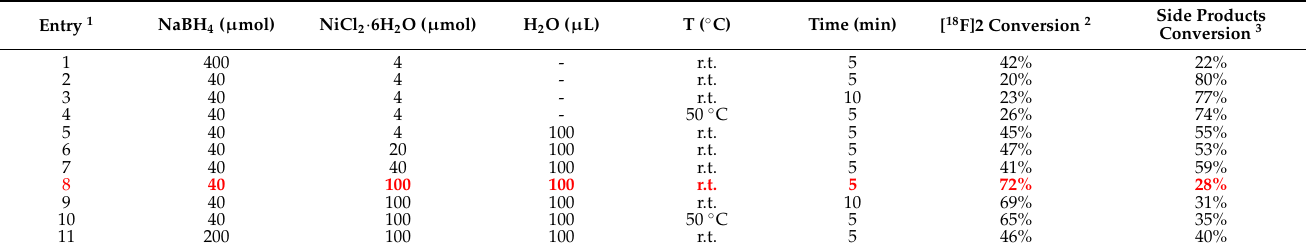
Table 3. Optimization of the nitrile reduction using NaBH 4 (2M) and NiCl 2 ∙ 6H 2 O as reducing